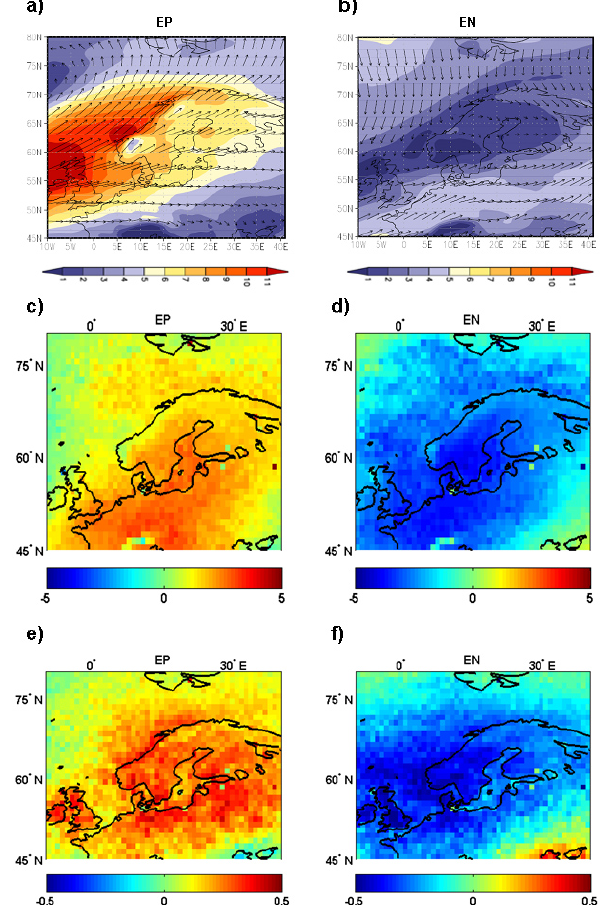
Figure 6. An overview of meteorological conditions at 850hPa dur- ing enhanced positive (EP) and negative (EN) phases of the Arctic Oscillation. The top row ( a and b ) shows wind conditions (ms − 1 ), the middle row shows temperature anomalies ( c and d ; in K) and the bottom row shows water vapour mass mixing ratio anomalies ( e and f ; in gkg − 1 ). The data from November through March from 2003–2012 are